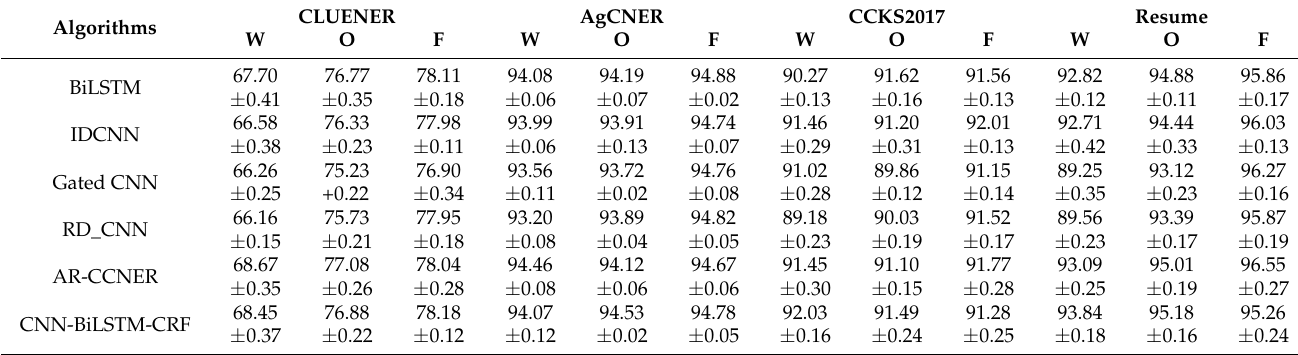
Table 5. F 1 of models with word2vec, original BERT, and fine-tuning BERT without adversarial training.